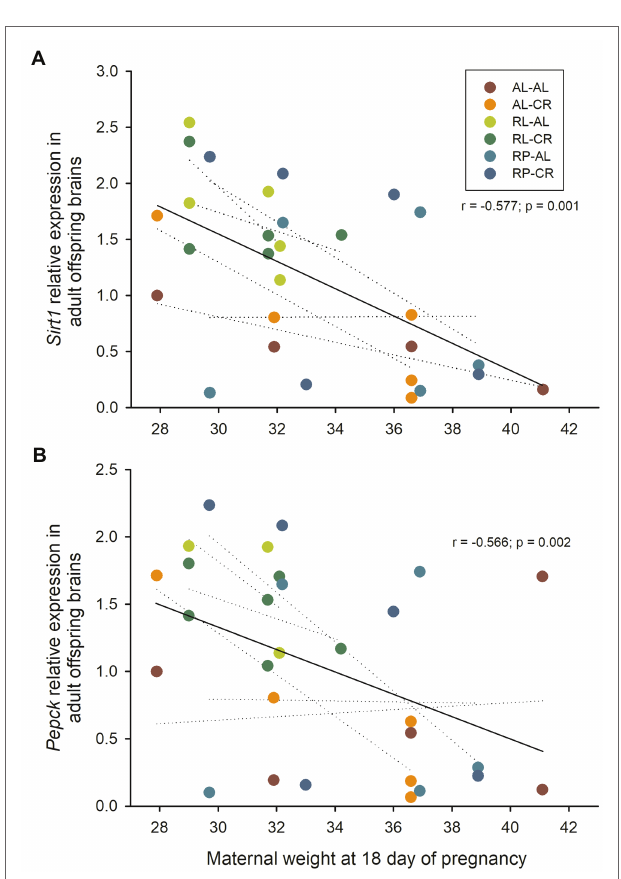
FIGURE 6 | (A) Relationship between Sirt1 relative expression (respect to B2m ) in the brains of adult male BALB/c mice, and the body weight of their mothers at the end of pregnancy. (B) Relationship between Pepck relative expression (respect to B2m ) and maternal body weight. Dashed line: linear regression of each